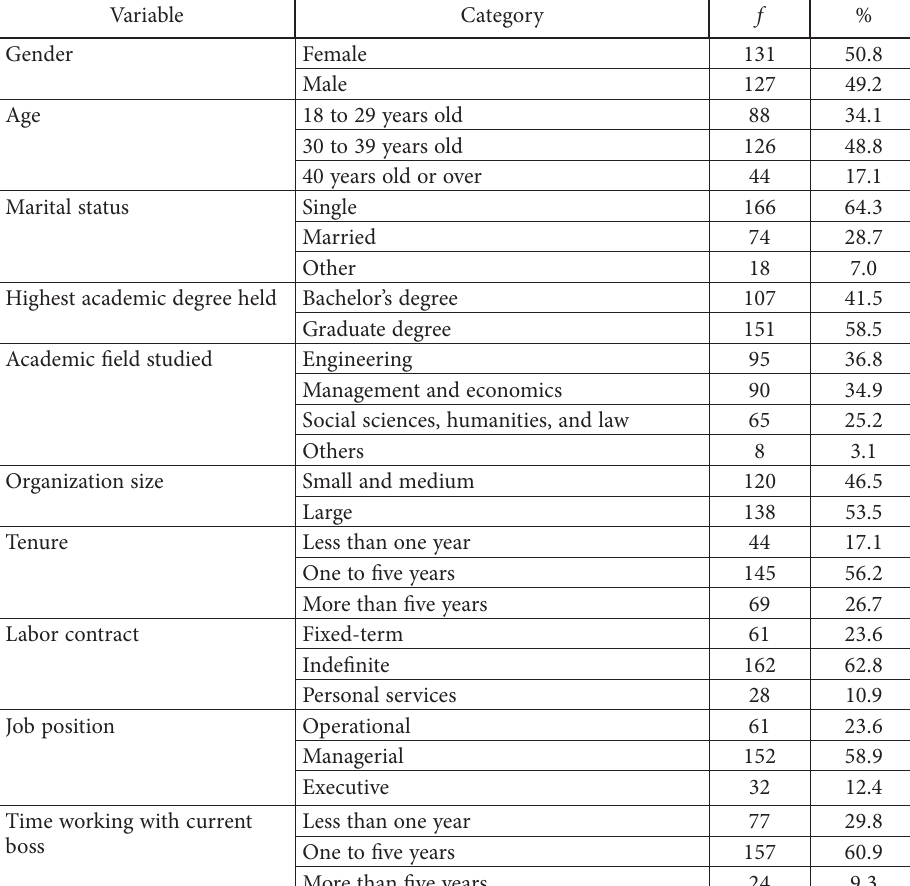
Table 1. Demographic and work characteristics of the study participants (n = 258) (source: created by authors) Variable